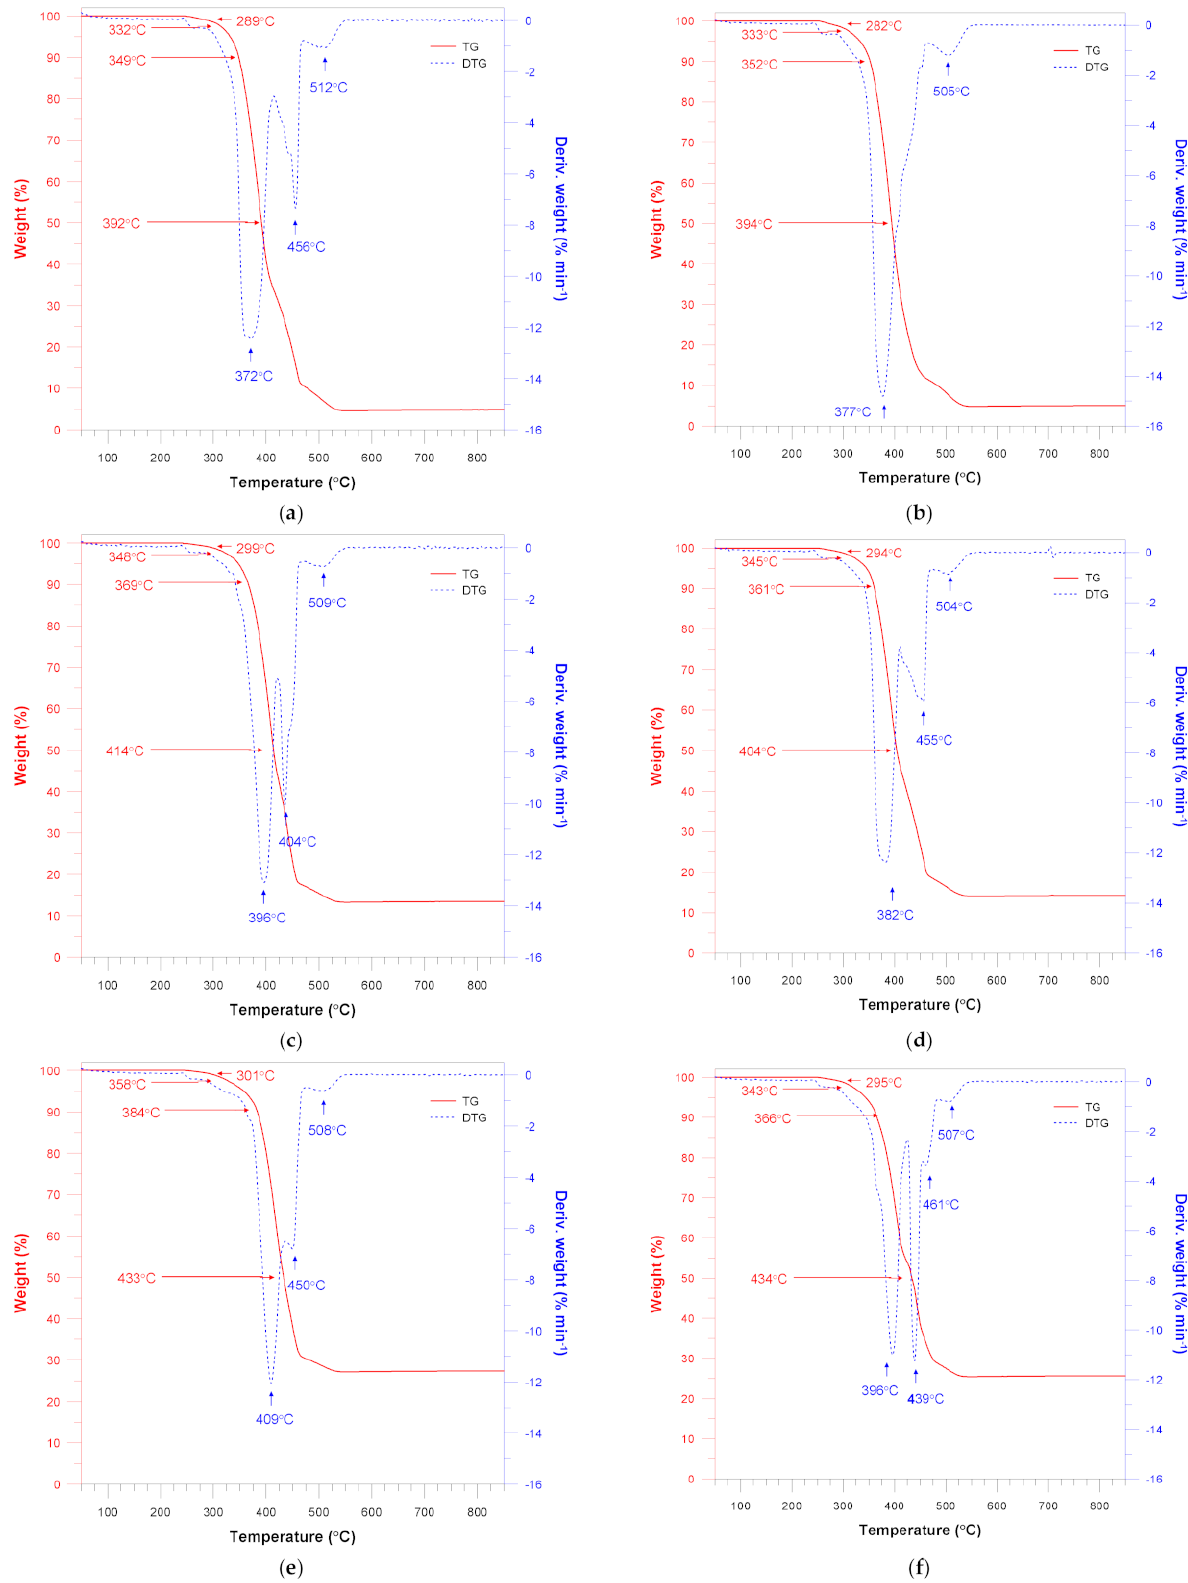
Figure 11. Thermal decomposition of the LLDPE/QF materials: ( a ) LLDPE/5%QF; ( b ) LLDPE/5QF/ HDPE-g-MA; ( c ) LLDPE/15%QF; ( d ) LLDPE/15QF/HDPE-g-MA; ( e ) LLDPE/35%QF; ( f ) LLDPE/